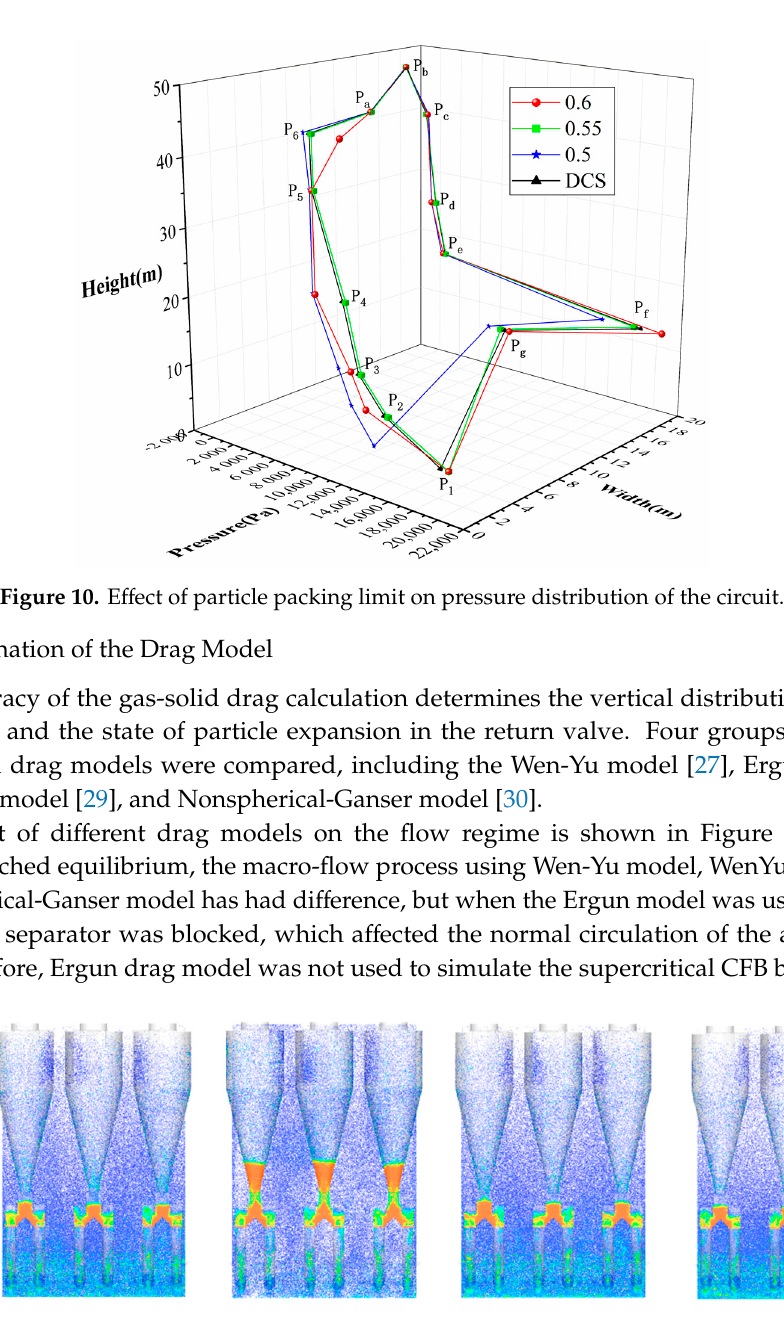
Figure 12. Effect of drag model on pressure distribution of the circuit. 4.1.3. Grid Independence Test The quality of the grid directly affects the accuracy of the calculation. In addition, for industrial- level simulation calculations, at least 500,000 cells are required to capture enough information for the